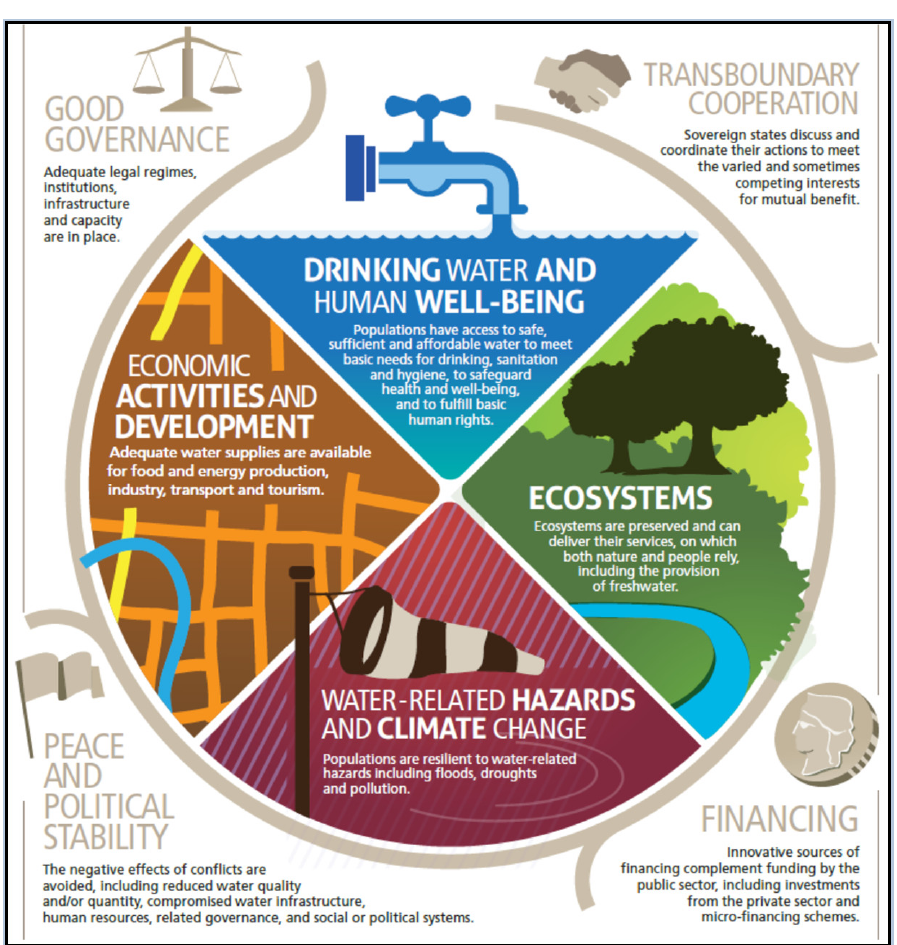
Figure 1. The UN Water (2013) water security conceptual framework outlines key dimensions that remain crucial to designing and implementing interventions and plans toward water security and climate-resilient communities and regions.